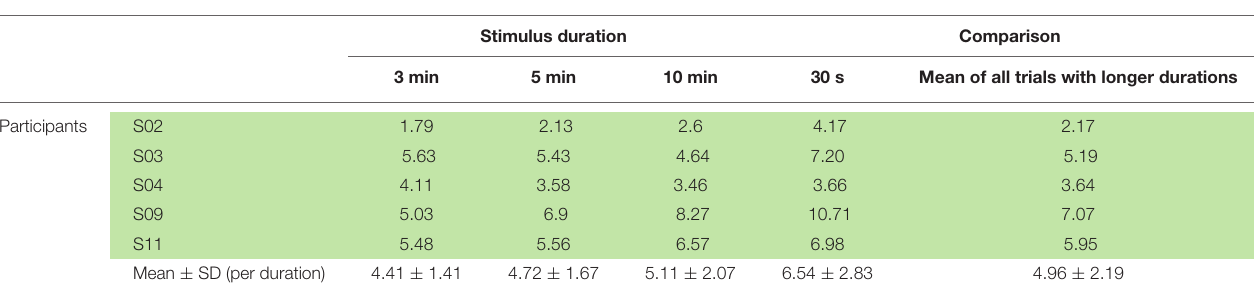
TABLE 3A | OKAN-I peak velocity (deg/s): participants with OKAN-II.